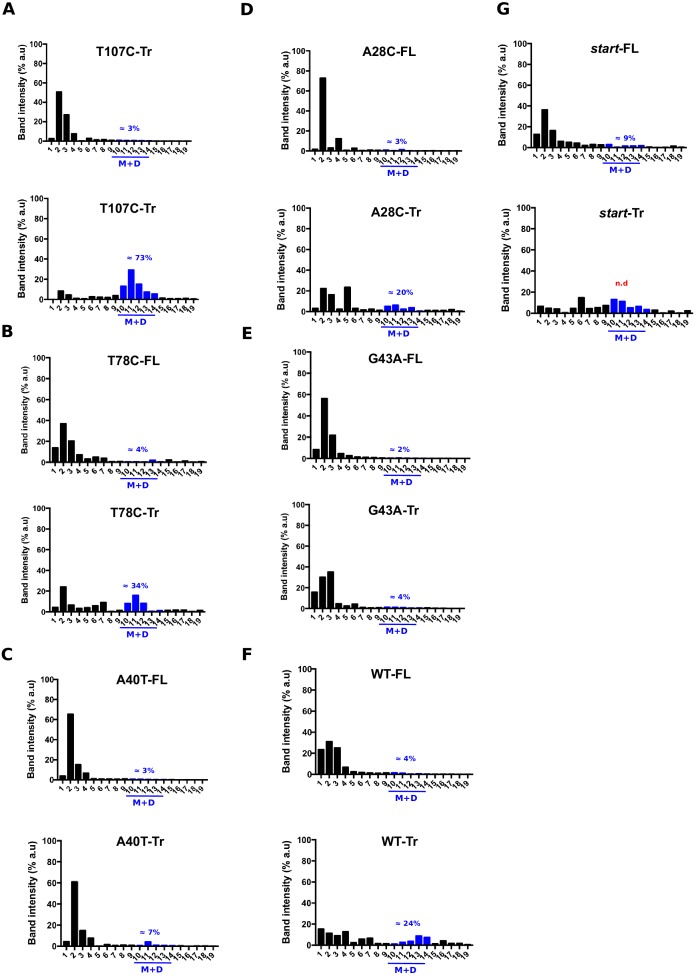
Quantification of the relative aapA3 mRNA band intensity from polysome fractionation Northern Blots shown in Figure 4.Relative band intensity was determined using the ImageLab software. Percentage of band intensity located in 70S fractions was calculated for each aapA3 transcript (full-length, -FL or truncated, -Tr) by dividing the band intensity in 70S fractions by the total band intensity (intensity values in all fractions). Each panel shows the data for a given WT or mutant transcript. The blue line represents monosomes and disomes. In the case of the start (G54T/pIsoA3*) strain, the quantification of the aapA3-Tr form present on the M+D fractions was not possible due to a strong mRNA degradation (n.d = non detectable).